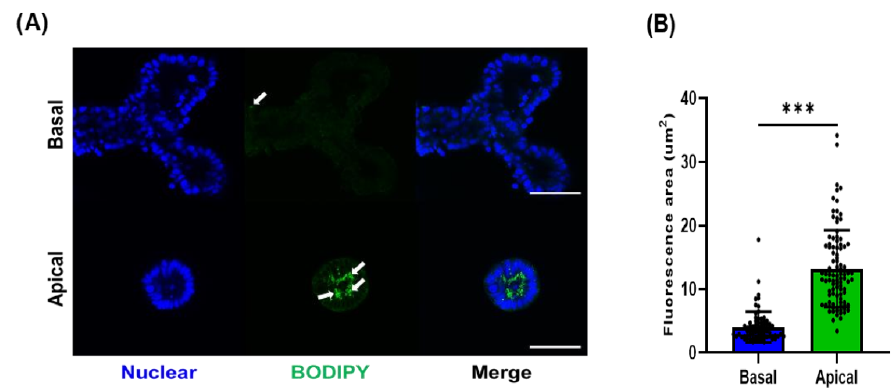
Figure 4. The BODIPY uptake for porcine small intestinal organoid. ( A ) Representative organoid images for basal-out and apical-out organoids treated with fluorescent fatty acid analog (BODIPY) (magnification: × 400). Each organoid was treated with BODIPY for 30 min, then staining was performed. Nuclear was stained by DAPI. Scale bar (100 µ m). ( B ) Quantification of fatty acid analog uptake in porcine organoids. Data are represented as mean ± SD ( n = 10, 7–10 fluorescence area/organoids). The significance between basal-out and apical-out organoid was analyzed by two-tailed unpaired Student’s t -test. *** p <